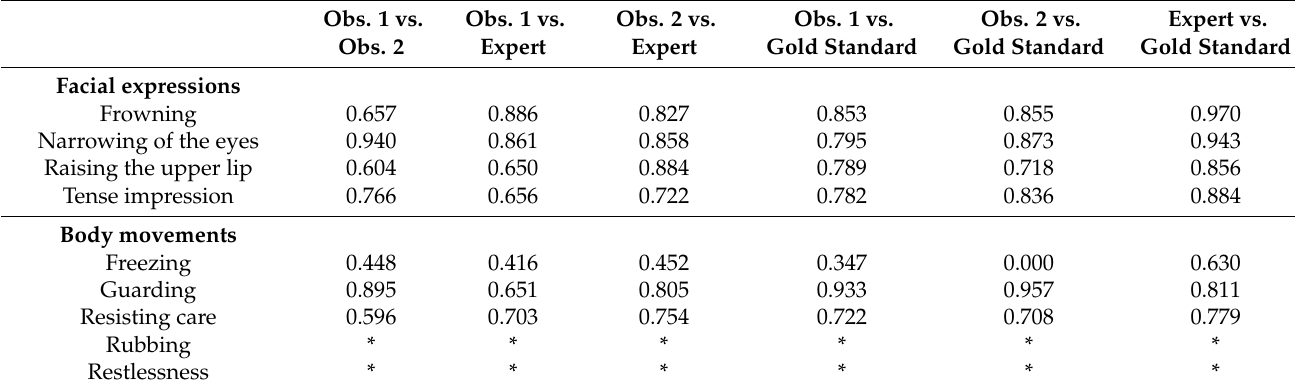
Table 2. Intraclass correlation coefficients (ICCs) scores for the inter-observer reliability measurements between the observers in scoring pain-related facial expressions and body movements. Scores are based on the first assessment.